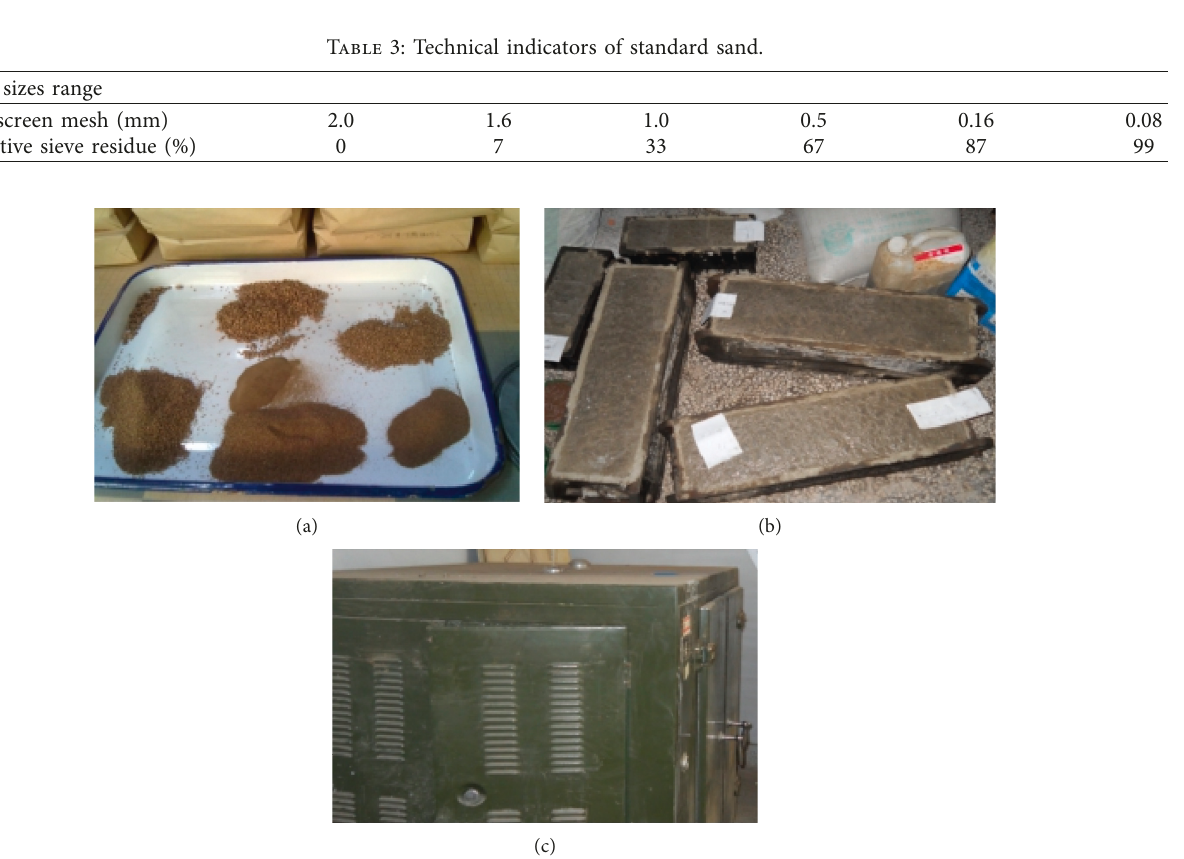
Figure 1: Preparation of geopolymer concrete specimen. (a) Raw materials for experiment. (b) Coal gangue-based geopolymer concrete specimen. (c)